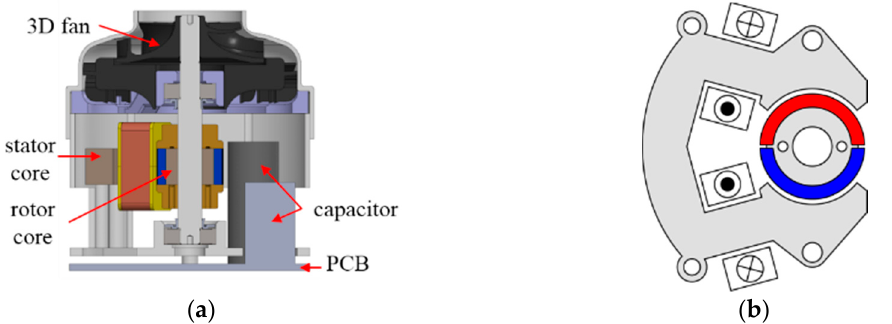
Figure 1. Research prototype of an inverter-driven single-phase brushless direct-current motor unit: ( a ) system profiles; ( b ) electromagnetic field structure of a single-phase BLDC motor.